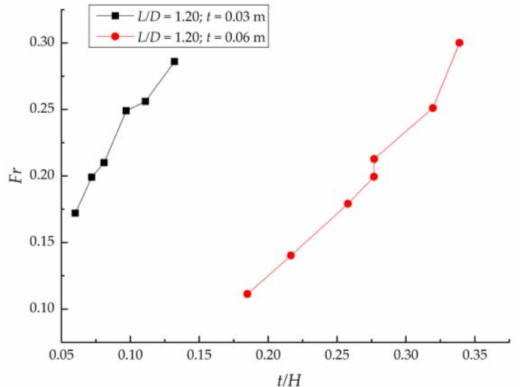
Figure 7. Relationship between critical Fr and t / H for di ff erent ice